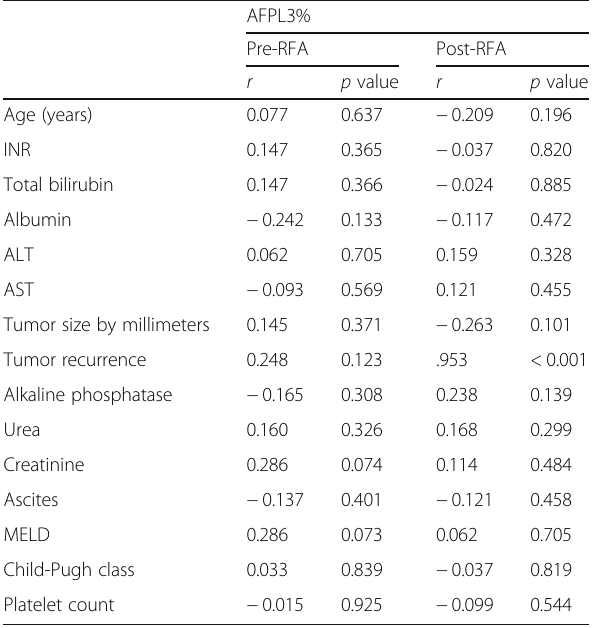
Table 3 Correlation between AFP-L3% and other parameters using Pearson ’ s correlation coefficient in the patients ’ group